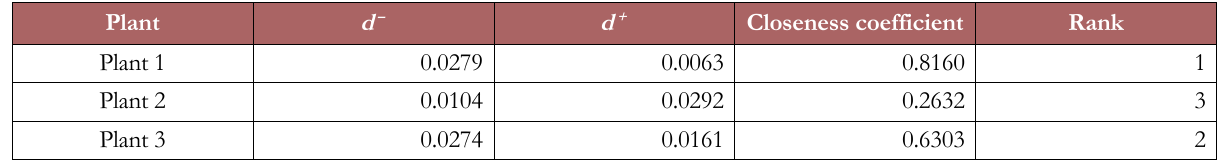
Table 18. Distance, closeness coefficient and the rank of each plant (big data)